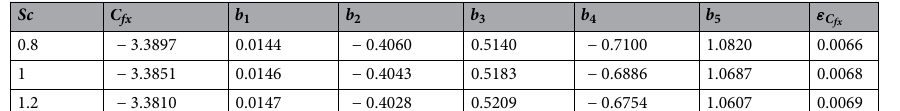
Table 5. Numerical computations for quadratic regression coefficients and error bound for estimated C fx Re